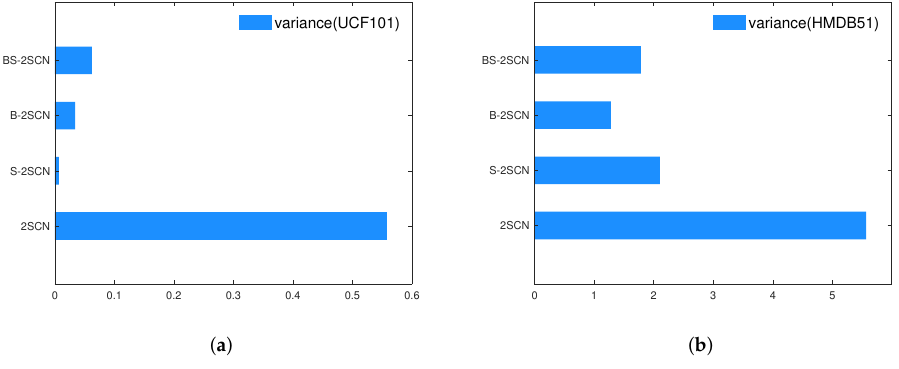
Figure 11. variances of multiple experiment. ( a ) UCF101. ( b )